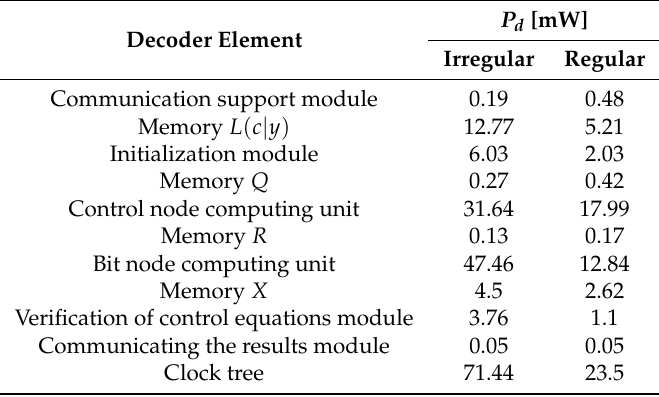
Table 4. Comparison of energy losses of elements of regular and irregular